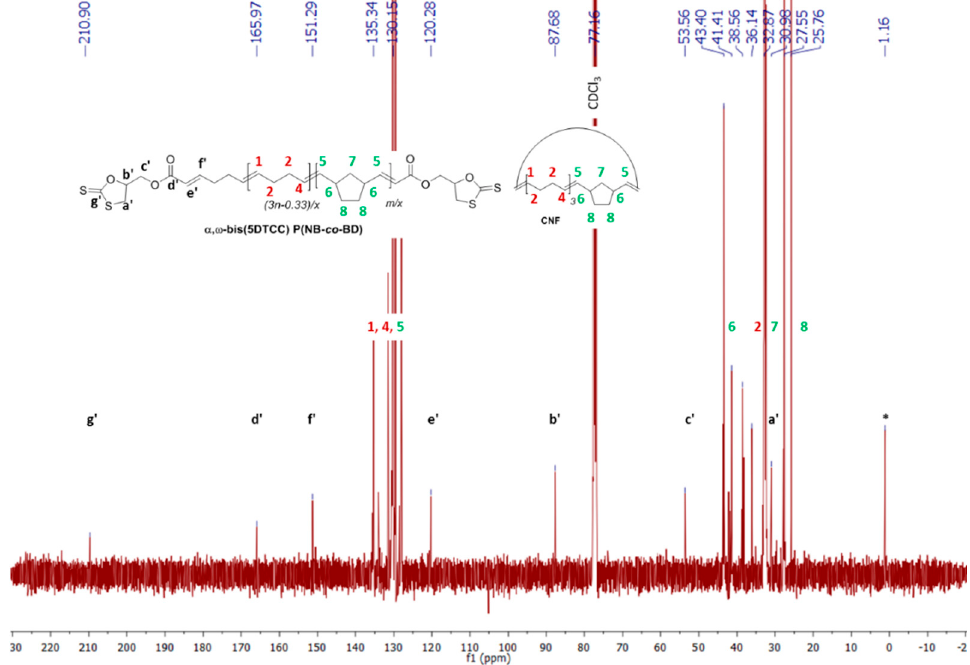
Figure 6. 13 C{ 1 H} NMR spectrum (125 MHz, CDCl 3 , 25 °C) of an α , ω -bis(dithiocarbonate) P(NB- co -